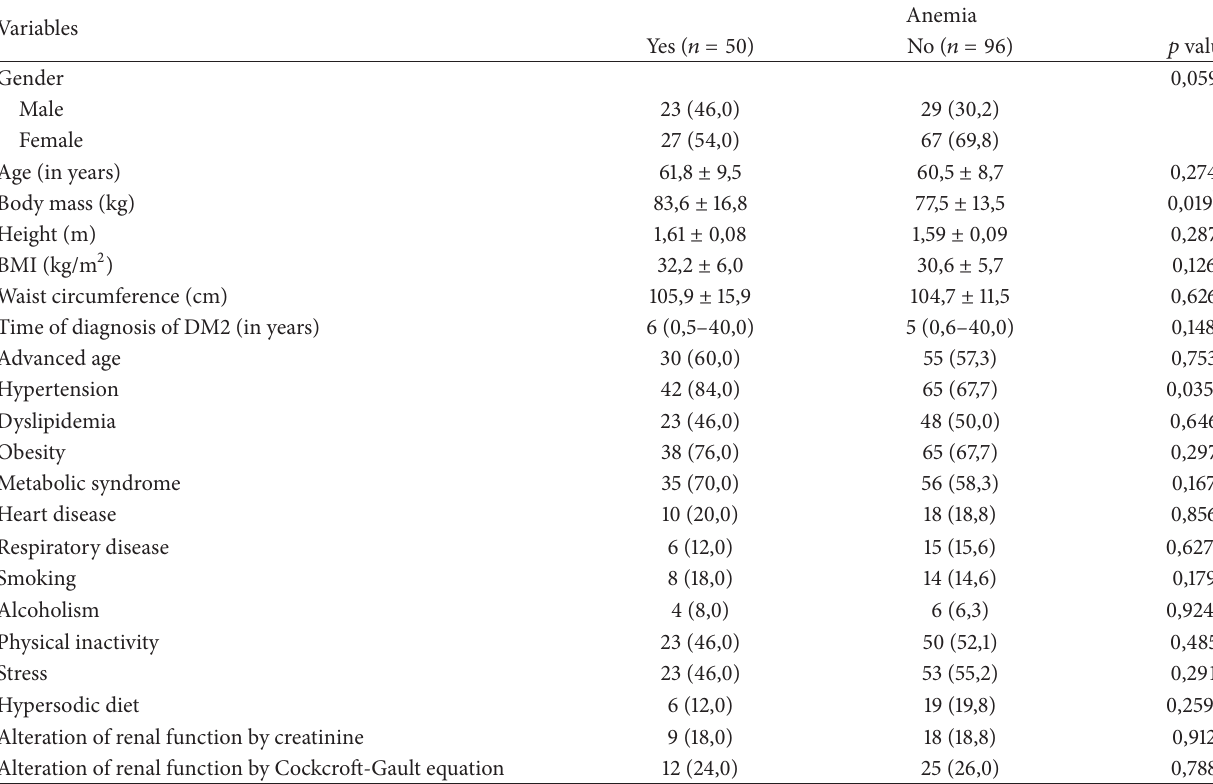
Table 1: Characteristics of patients with diabetes mellitus type 2 according to the presence of anemia.